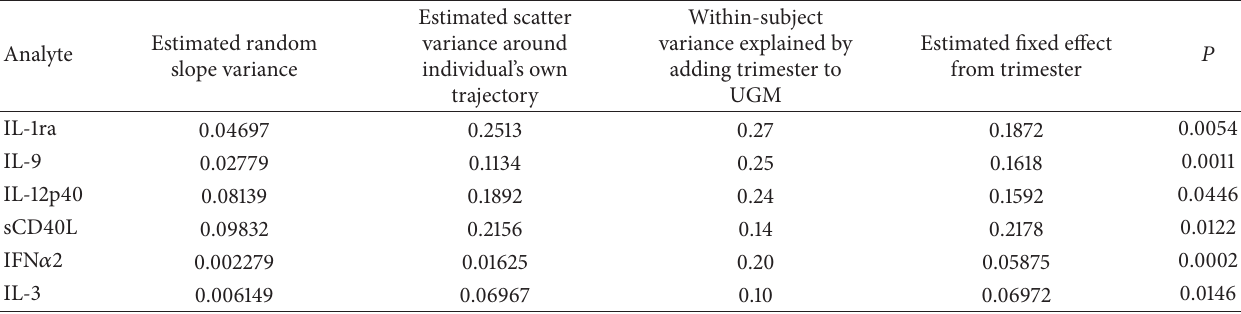
Table 3: Cytokines with linear trimester as the time covariate, ordered by decreasing within-subject variance explained by adding trimester to the unconditional growth model (UGM).